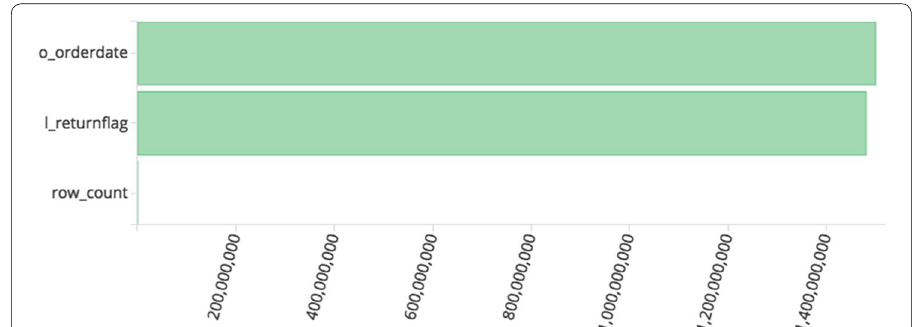
Fig. 13 Column validation chart for the difference count. X-axis: Difference count Y-axis: Column name